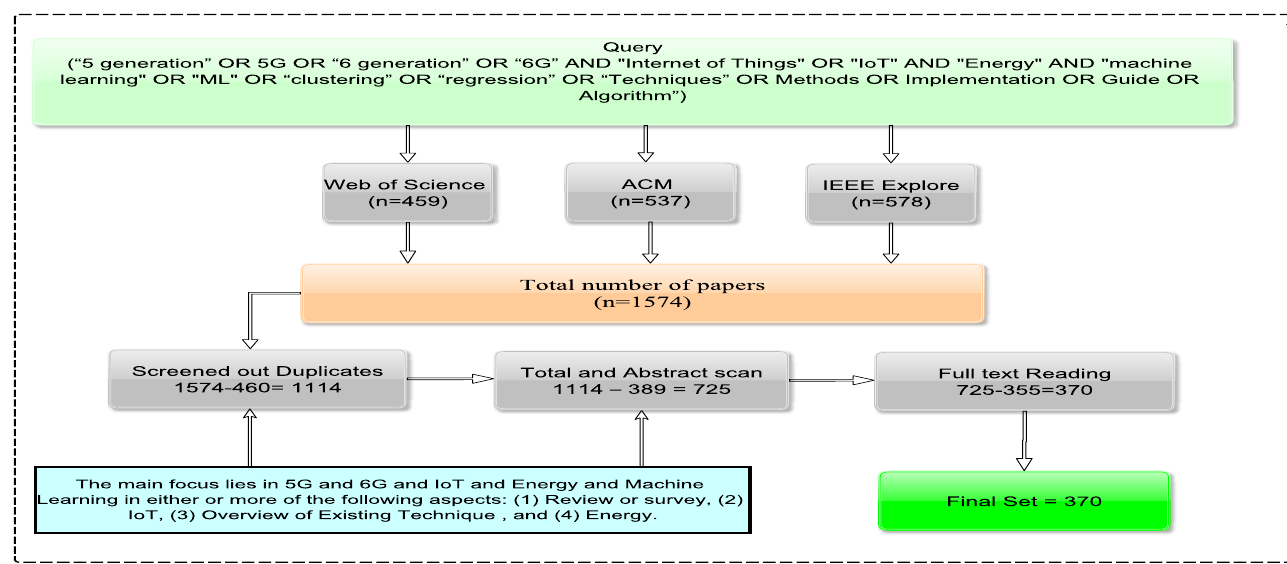
Figure 1. Research Methodology